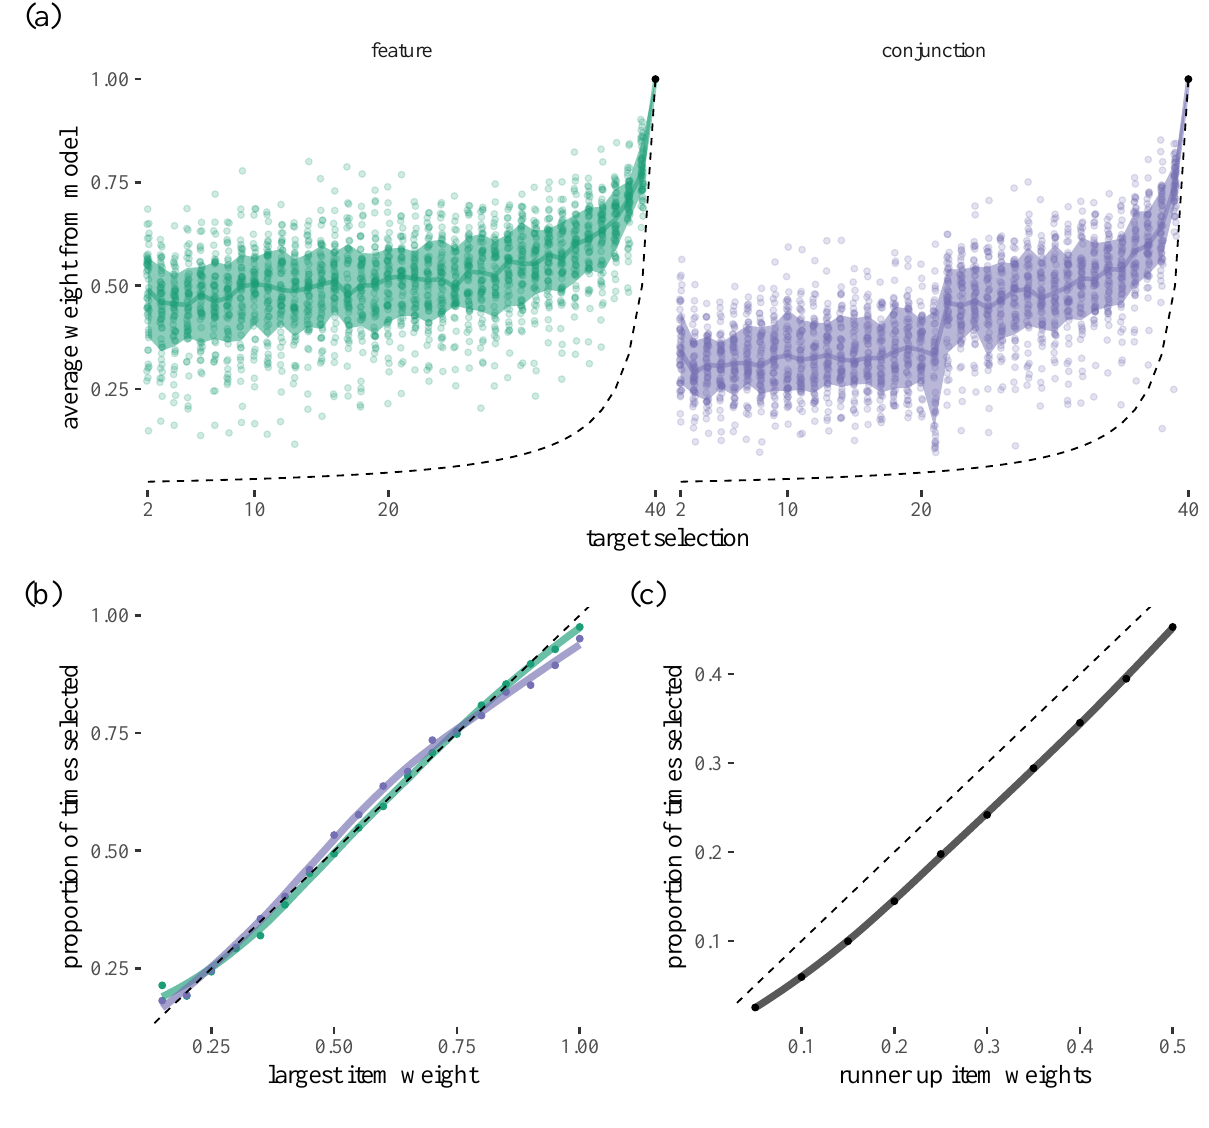
Figure 1. ( a ) Top left: Posterior probabilities for target selections during a visual foraging task. Each dot shows the data from an individual participant, averaged over trials, in the feature condition and the shaded region indicates the interval in which we expect 67% of participants to fall. The dashed line indicates chance performance. Top right: As top left, except showing the conjunction condition. ( b ) Calibration plot for our foraging model. The x -axis gives the largest weight assigned by the model while the y -axis shows how often that target was actually selected by a human participant. The dashed line here and in the right plot is the identity line. ( c ) This plot shows how often the model selects the 2nd and 3rd ranked items based on the weights assigned by the